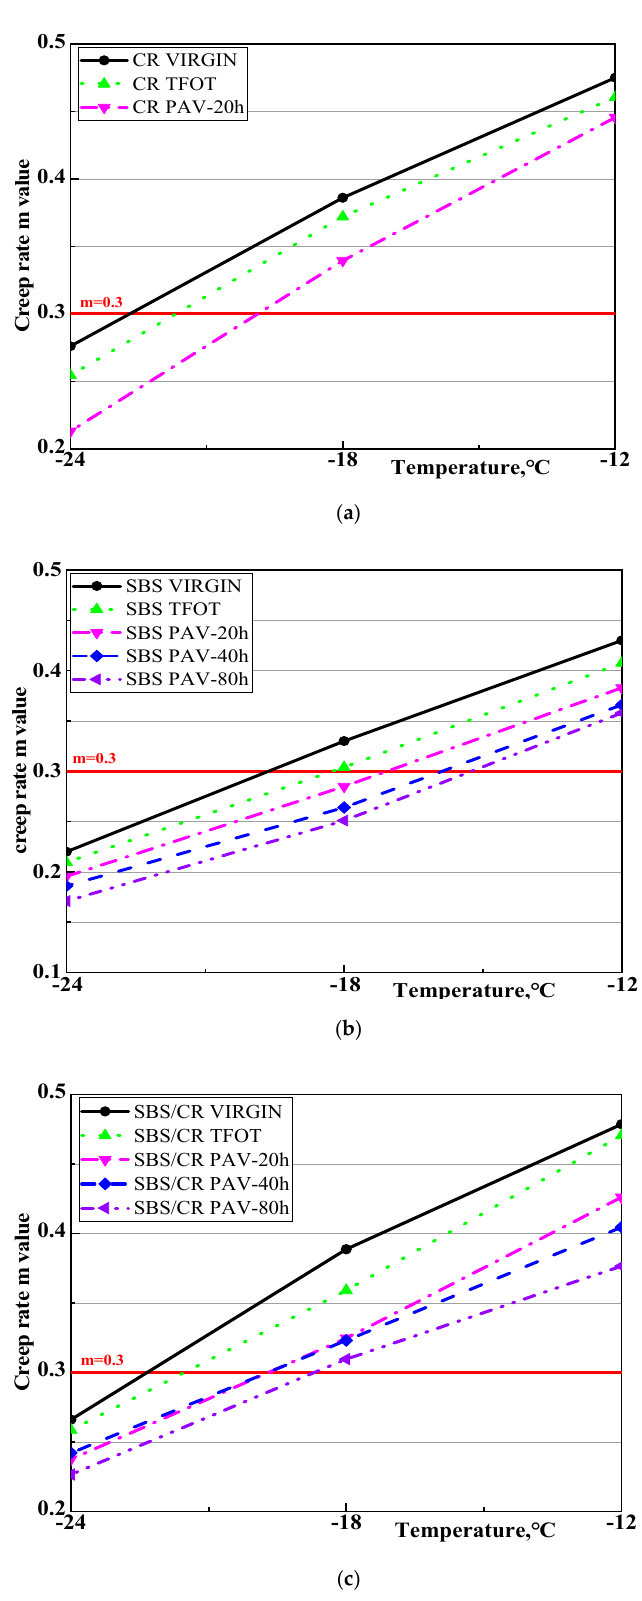
Figure 8. The evolution of creep rate under different aging conditions of all selected asphalt binders, ( a ) Crumb Rubber modified binders; ( b ) Styrene-butadiene-styrene Modified binders; ( c ) Styrene- butadiene-styrene/Crumb Rubber Modified binders.